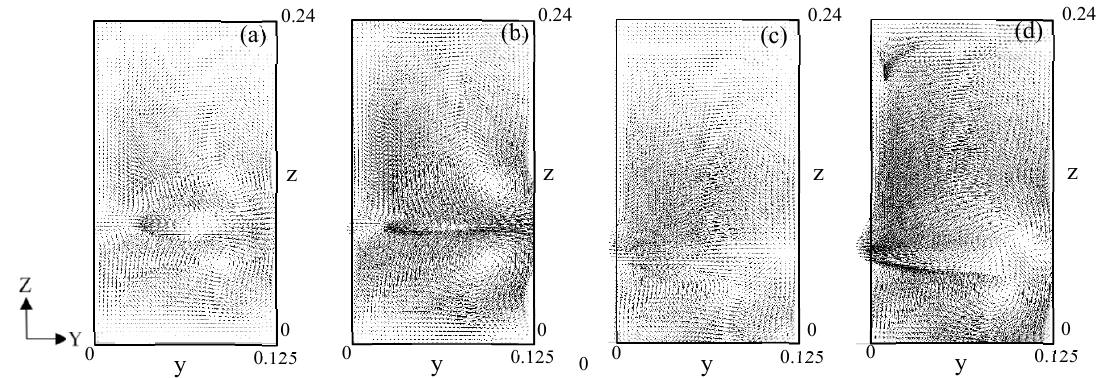
Figure 8. The velocity field from experimental measurement at Re = 28,692 ( a , c ) and at Re = 57,384 ( b , d ) for the Rushton turbine ( a , b ) and the Novel-1 impeller ( c , d ).